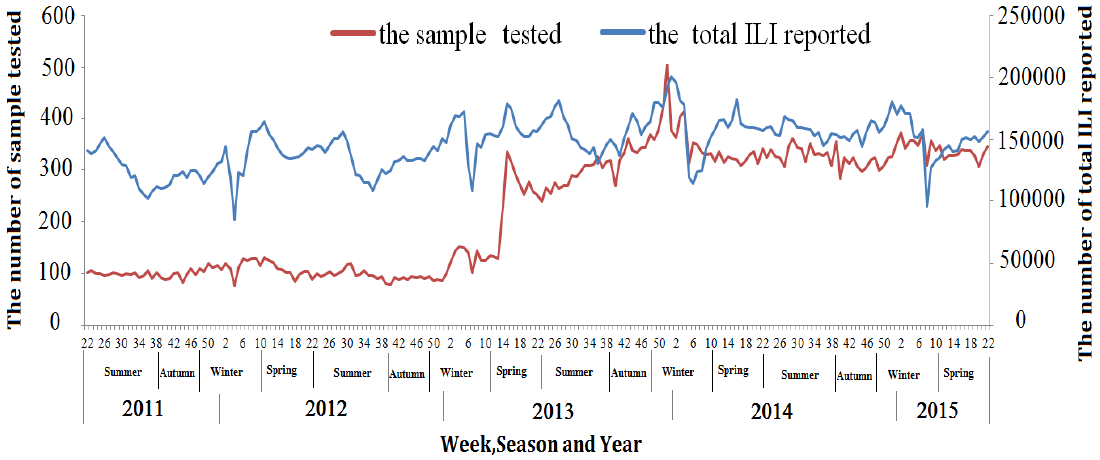
Figure 4. Temporal distribution of the weekly number of the samples tested and all ILI patients, in Zhejiang Province, March 2011–June 2015. (ILI = Influenza-like illness).